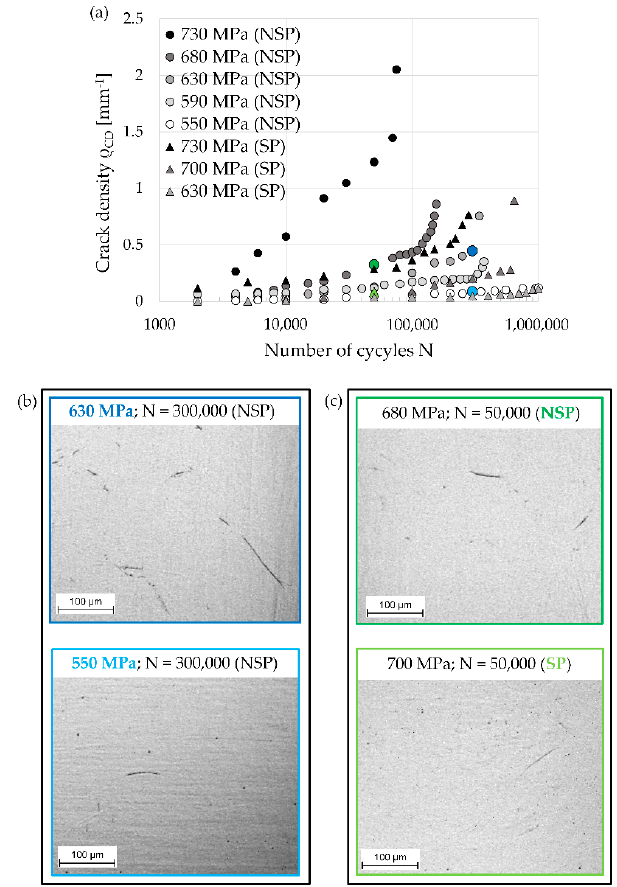
Figure 6. ( a ) Crack density ρ CD of the NSP samples and the SP samples as a function of the number of cycles for different stress amplitudes; ( b ) CLM images of two NSP samples of different stress amplitudes; ( c ) CLM images of an NSP sample and an SP sample of similar stress